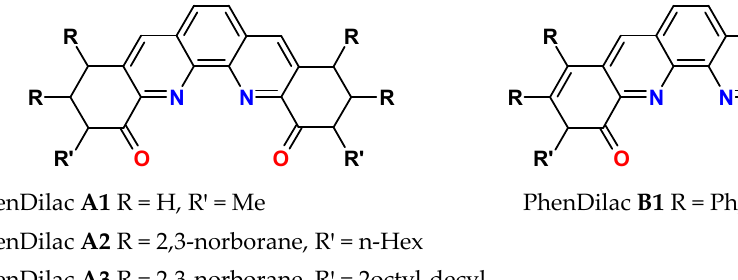
Figure 9. Structures of studied Phen-dilactams.